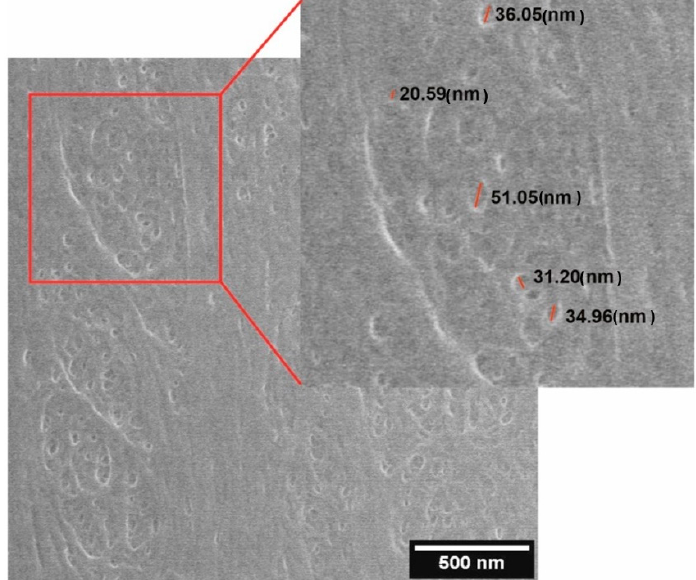
Figure 3. An exemplary Environmental Scanning Electron Microscopy (ESEM) micrograph of the dialysis membrane surface, with the sizes of several pores indicated.